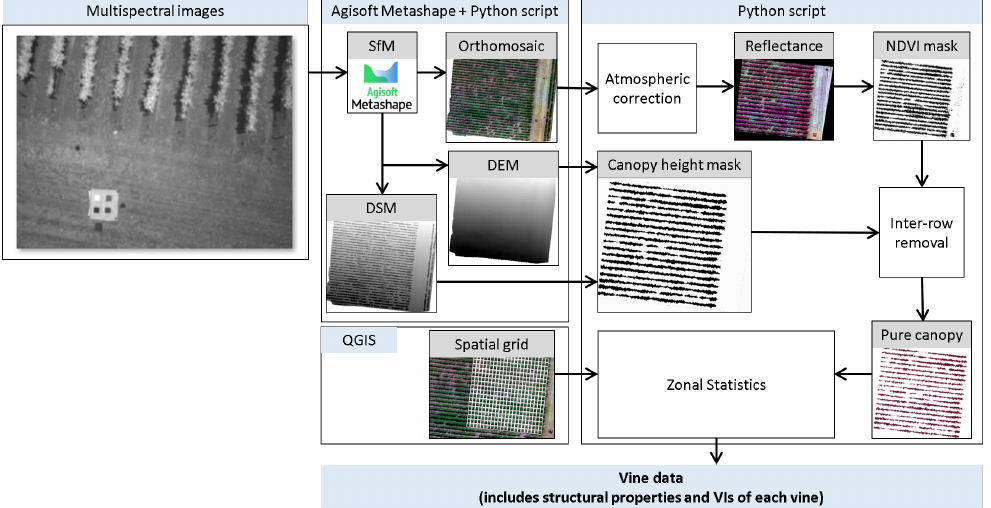
Figure 4. The workflow developed to process the UAV-based images and extract the canopy-specific structural information and spectral